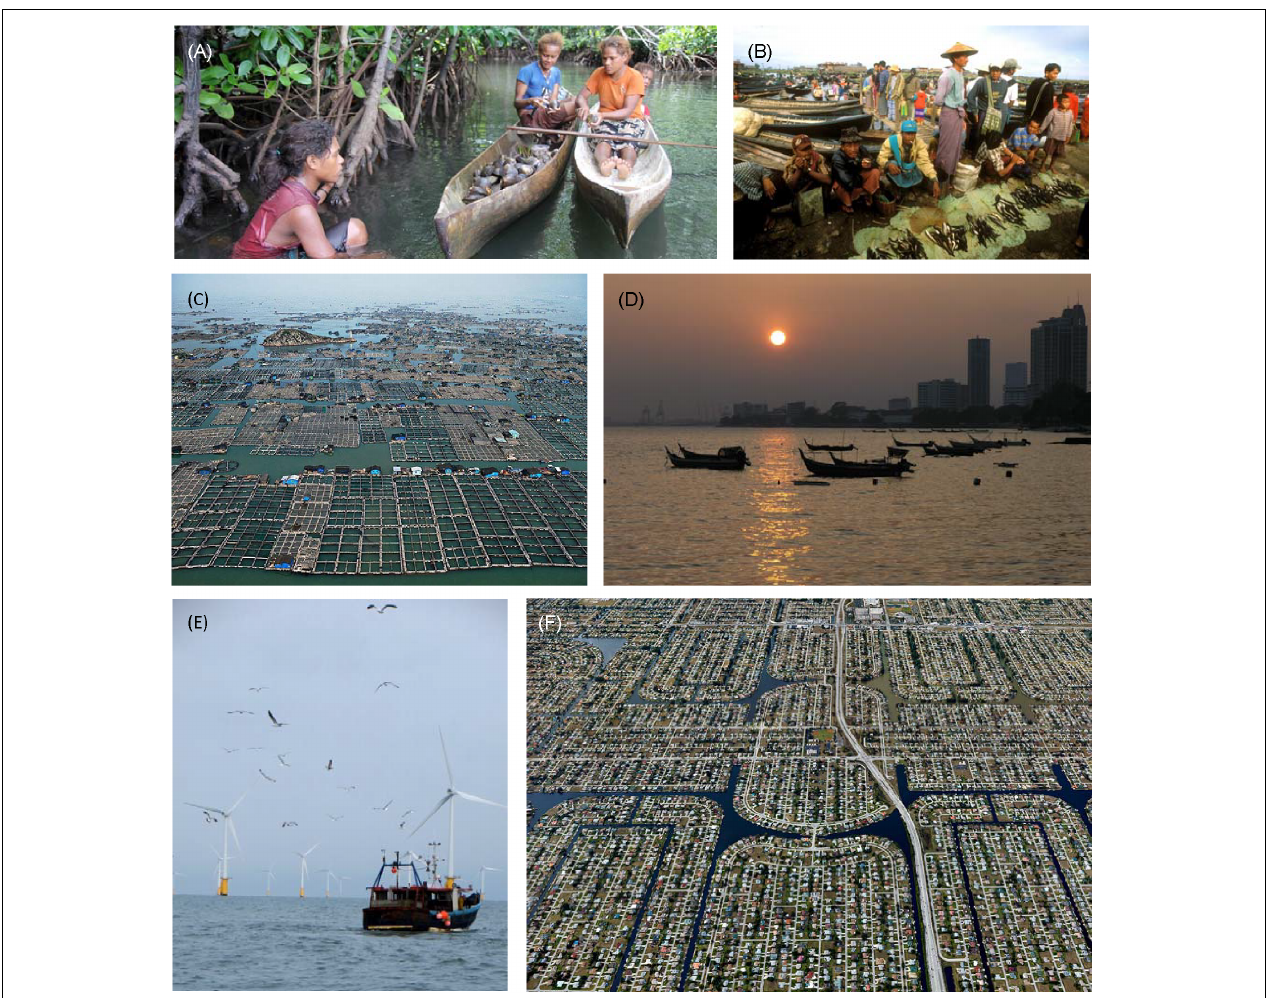
FIGURE 1 | Small-scale fisheries, amidst contemporary pressures on coastal systems and ocean space. (A) In developing countries fish caught by SSF are an important source of protein and essential micro-nutrients – often in these contexts nutritional alternatives are limited. Men, and women, are active in SSF harvesting, post-harvest processing and marketing [Wade Fairley (copyright – used with permission), Malaita Province, Solomon Islands, 2012]. (B) Informal fisheries market chains contribute to livelihoods of hundreds of millions of people [Dominyk Lever (copyright – used with permission), Cambodia, 2004]. (C) Despite the growth of aquaculture, people in developing countries continue to rely on SSF, and will so for decades to come [Edward Burtynsky (copyright – used with permission), Luoyuan Bay, Fujian Province, China, 2012]. (D) In many regions SSF exist within increasingly contested ocean and coastal space [Jamie Oliver (copyright – used with permission), 2008, Penang, Malaysia]. (E) SSF can adapt to marine developments [Lorelei Stevens (copyright – used with permission), Commercial Fisheries News, River Thames, United Kingdom, 2013]. (F) but also can be squeezed out by expansive development or privatization [Edward Burtynsky (copyright – used with permission), Lee County, FL, United States,